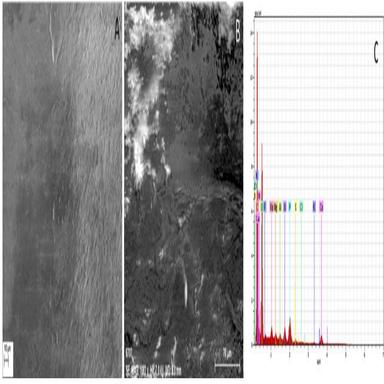
SEM images of MP debris: A – image acquired on 1 kV, B – image acquired on 7 kV, C – EDS spectrum acquired at 7 kV.